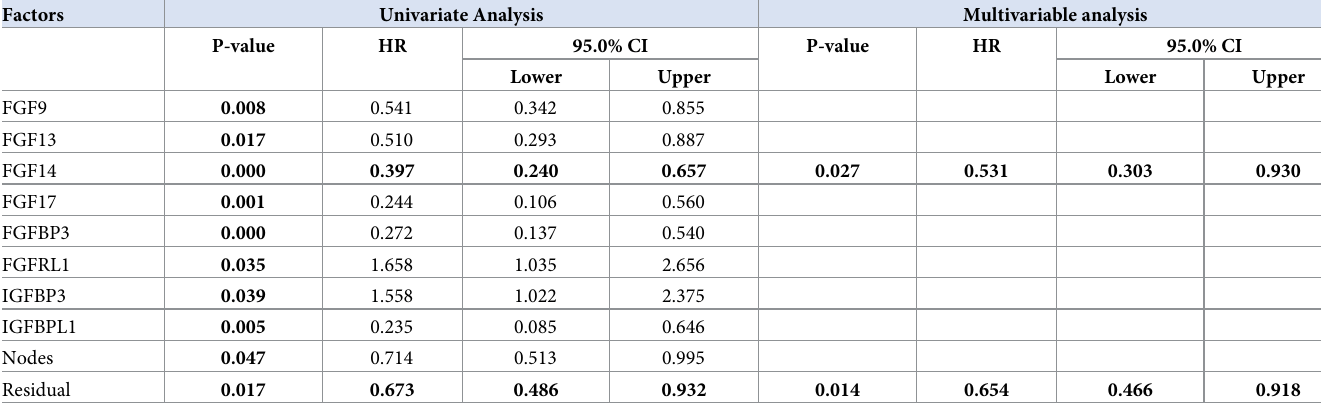
Table 2. Univariate and multivariate analysis of genes for overall survival in cohort 2.